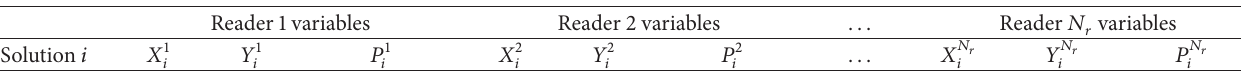
Table 5: Representation of an individual solution 𝑖 . Nr is the maximum number of RFID readers that are deployed in the working area. Reader 1 variables Reader 2 variables